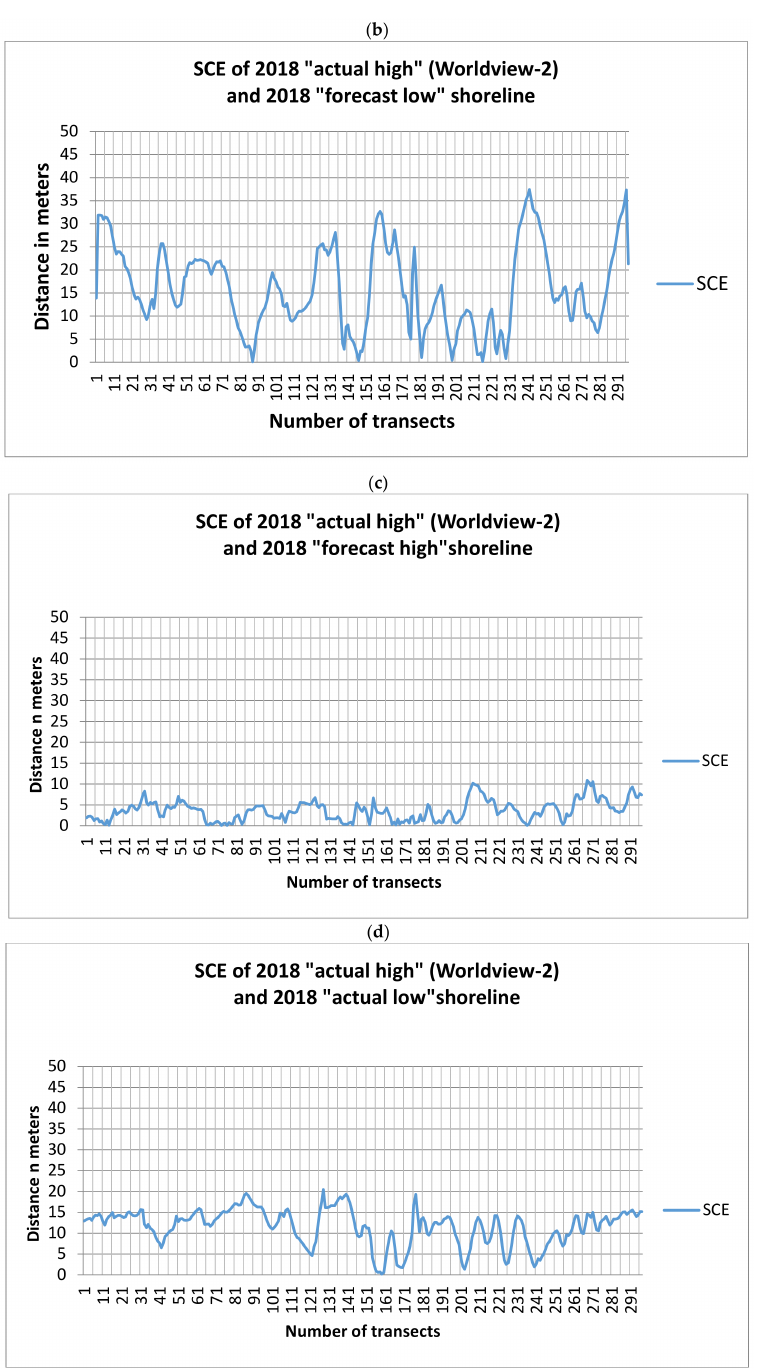
Figure 9. SCE statistical rates from low- and high-resolution vectorized shorelines in 2018 for Kalamaki beach. Figure 9a presents the SCE rates of the 2018 “actual low” Landsat 8 shoreline and the 2018 “forecasted low” shoreline, while Figure 9b presents the SCE rates of the 2018 “forecasted low” shoreline and the shoreline extracted from 2018 Worldview-2. Finally, Figure 9c shows the SCE rates of the shoreline extracted from the 2018 Worldview-2 “actual high” and 2018 “forecasted high” shoreline, while Figure 9d presents the SCE rates of the 2018 “actual high” and 2018 “actual low” Landsat 8 shorelines. In addition, the corresponding presentations, maintaining the same order, are also presented for Karnari beach in Figure